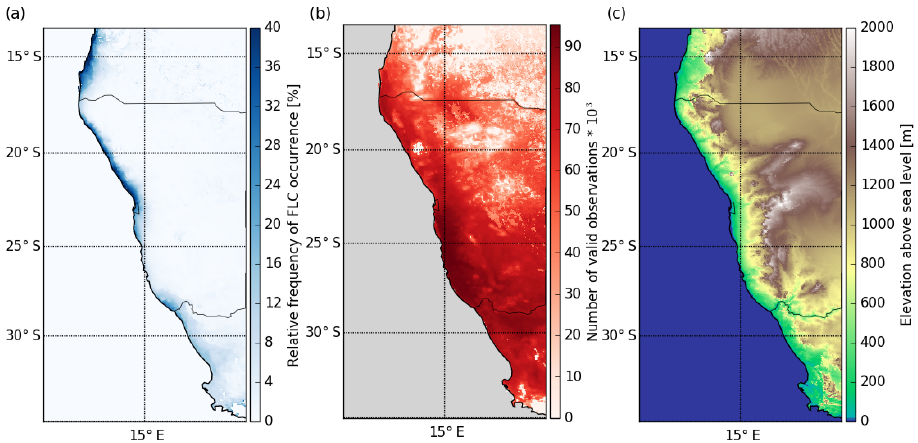
Figure 4. (a) Average relative frequency of occurrence of FLCs along the southwestern African coast during the period 2015–2017. (b) Num- ber of observations where the retrieval of FLCs is possible (i.e., no high clouds and no composite-related quality flags). (c) Digital elevation model of the study